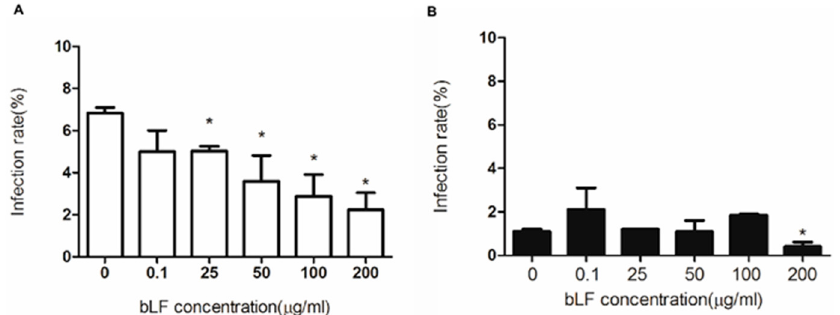
( A ) and HS-deficient CHO-pgsA745 ( B ) cells were pretreated with various concentrations of bLF for 1 hour at 37 ◦ C, then infected with DENV-2 at MOI of 5 for 1 h at 37 ◦ C, and analyzed by infectious center assay. The infection rate equals 100 × (plaque number/cell number) (* p < 0.05). Data are mean ± SD of three